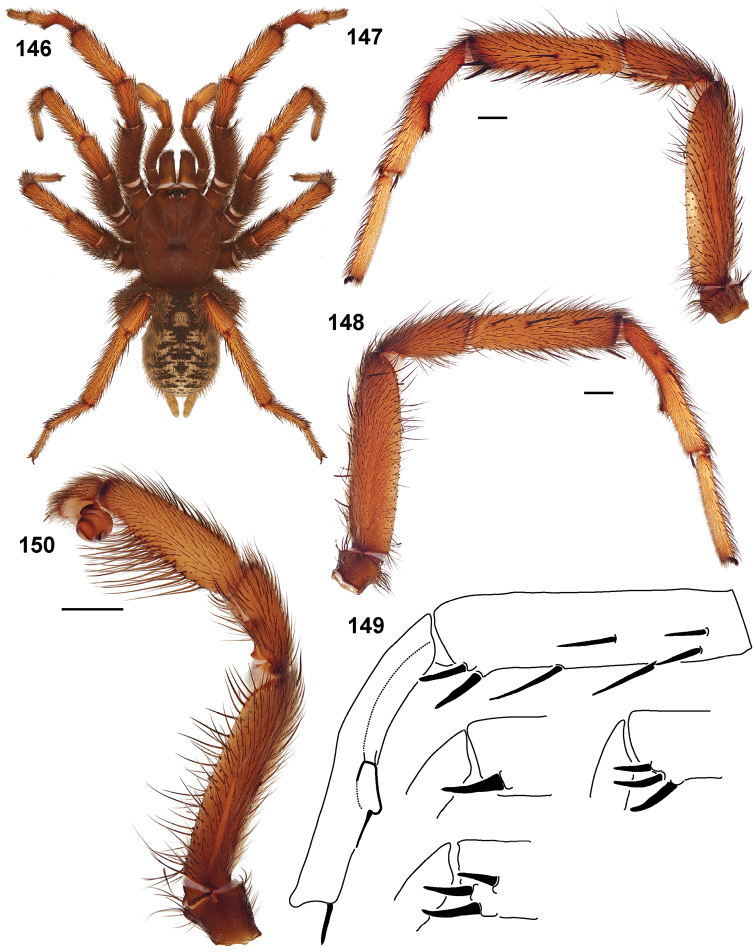
Aptostichus icenoglei sp. n.; scale bars = 1.0mm. 146–148, 150 male holotype from Riverside Co., Winchester (AP391) 146 habitus [805874] 147 retrolateral aspect, leg I [805866] 148 prolateral aspect, leg I [805870] 149 line drawings of leg I article spination patterns of holotype and additional specimens from the type locality 150 retrolateral aspect, pedipalp [805872].